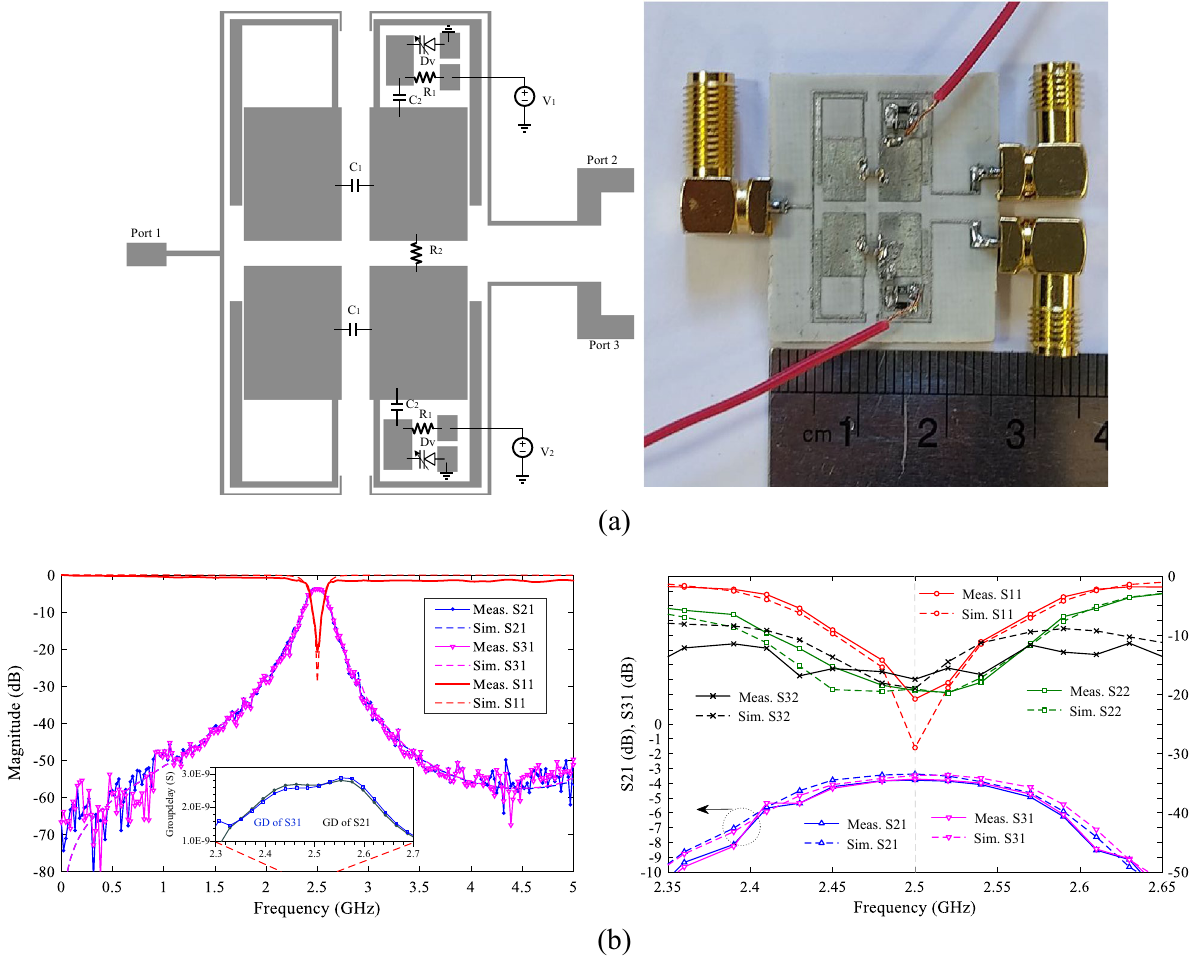
Figure 9. Proposed WPD with tunable power-dividing ratio (first design), ( a ) layout and photograph of fabrication structure, ( b ) simulation and measurement results at V1 and V2 = 8 V.